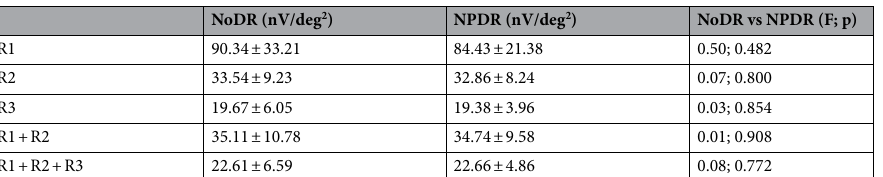
Table 3. Descriptive (mean ± SD) and inferential statistics (one-way analysis of variance, ANOVA) for multifocal electroretinogram N1-P1 response amplitude density (RAD) values in diabetic patients without diabetic retinopathy (NoDR) and mild signs of diabetic retinopathy (NPDR). R1 = ring 1, 0°–2.5° foveal eccentricity; R2 = ring 2, 2.5°–5° foveal eccentricity; R3 = ring 3, 5°°–10° foveal eccentricity; R1 + R2 = area covering 0°–5° foveal eccentricity; R1 + R2 + R3 = area covering 0°–10° foveal